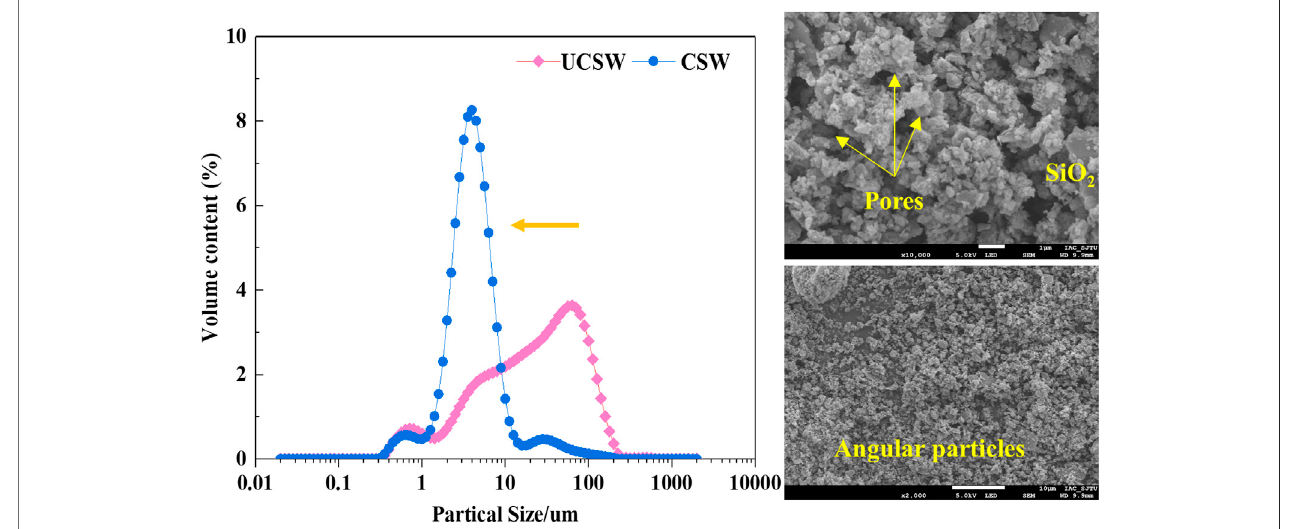
FIGURE 3 | Particle size distribution and SEM morphology of the homogenized